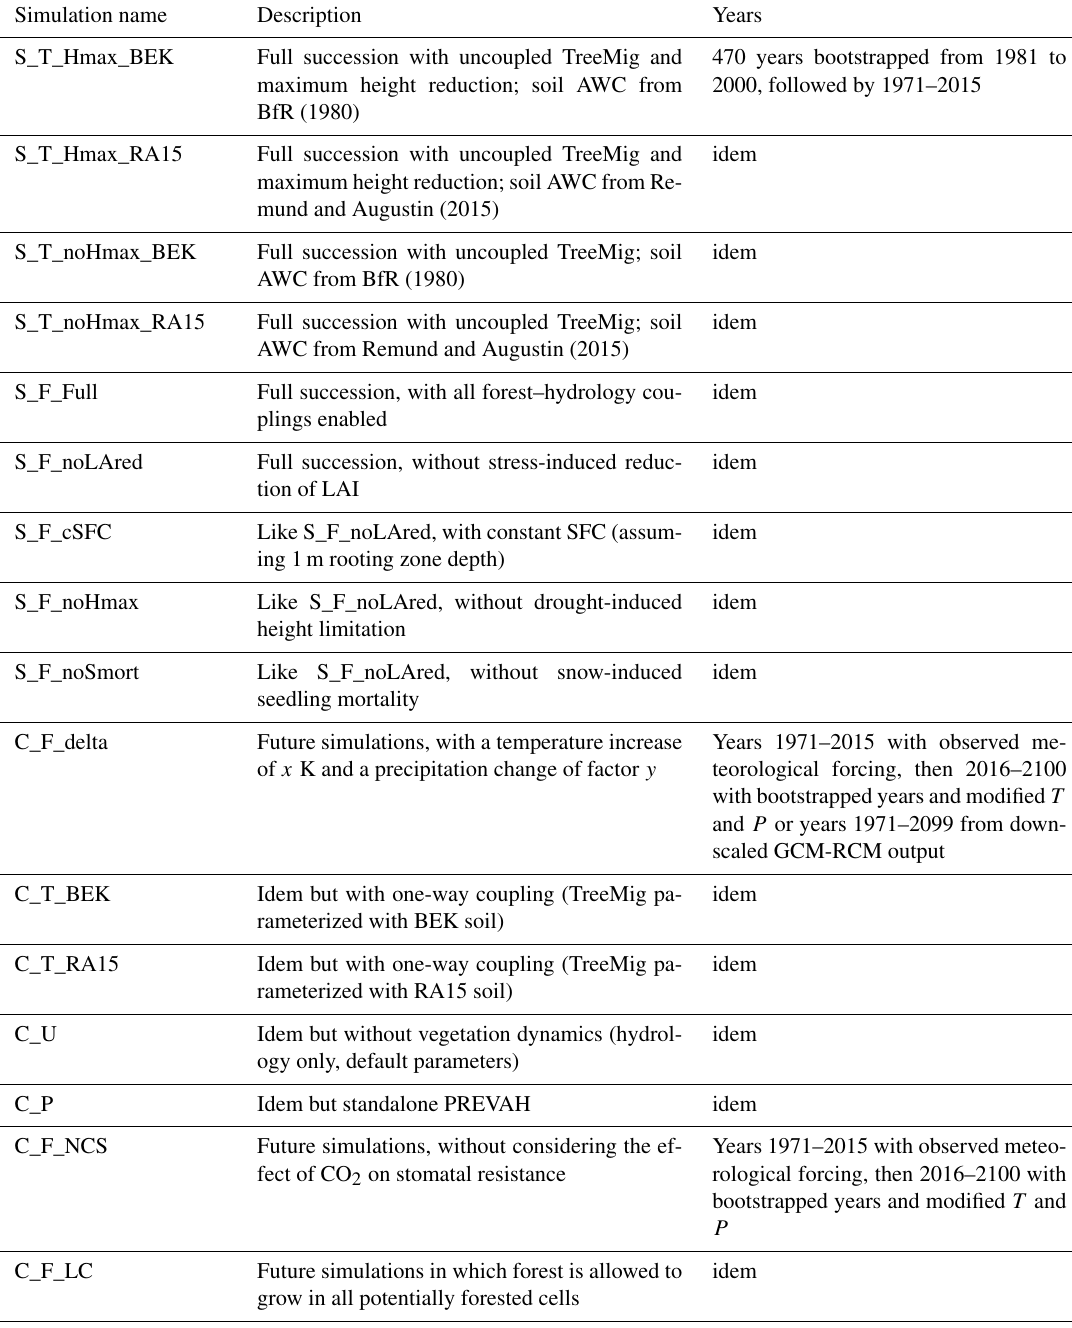
Table 1. Overview of the conducted simulation